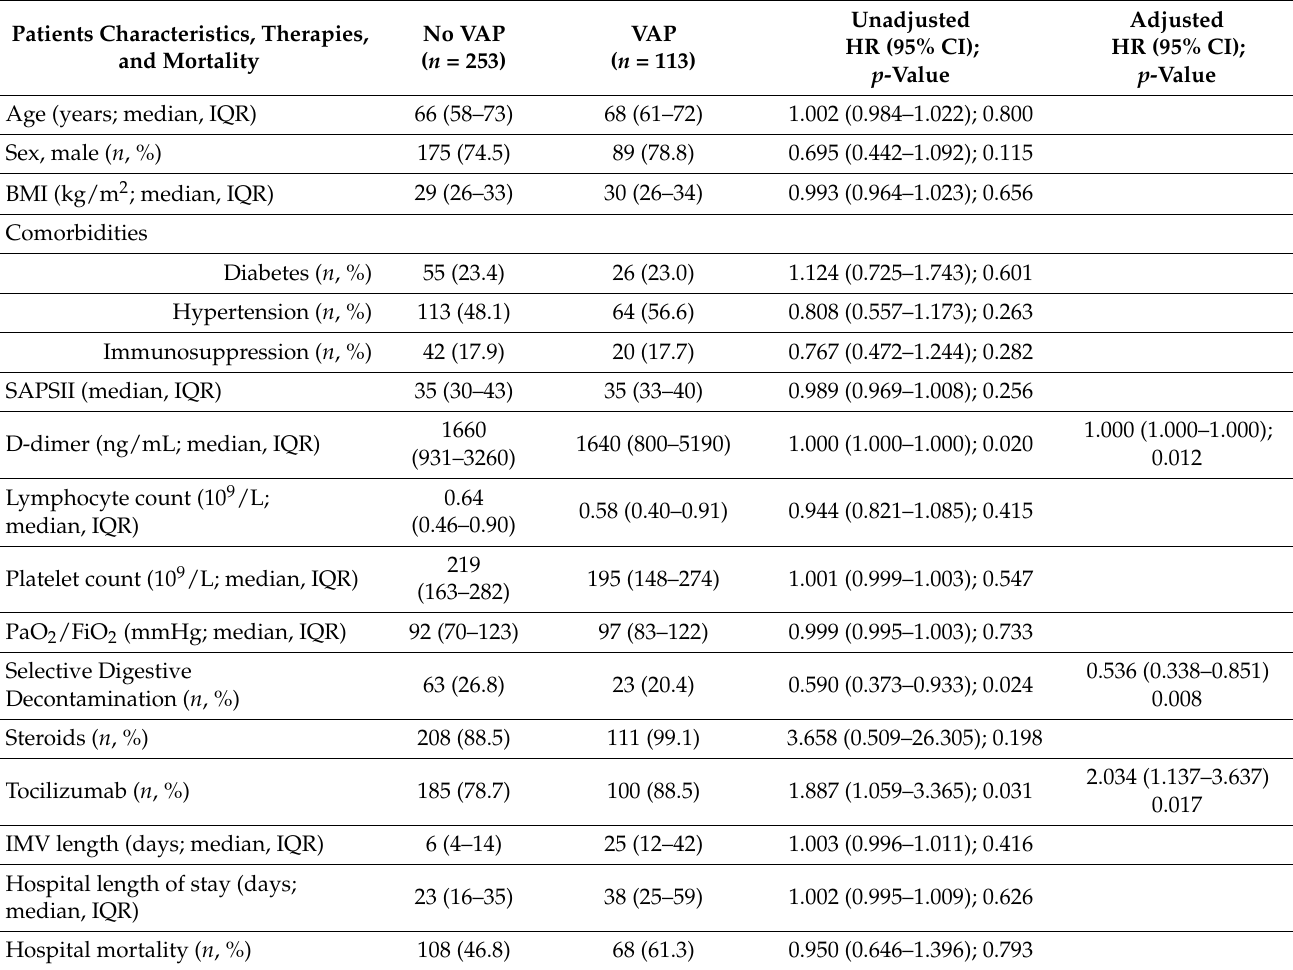
Table 3. Demographics, comorbidities, severity scores and laboratory at ICU admission, use of steroids and tocilizumab, hospital length of stay, and mortality in patients with or without ventilator- associated pneumonia. Unadjusted and adjusted analyses (see methods) are also